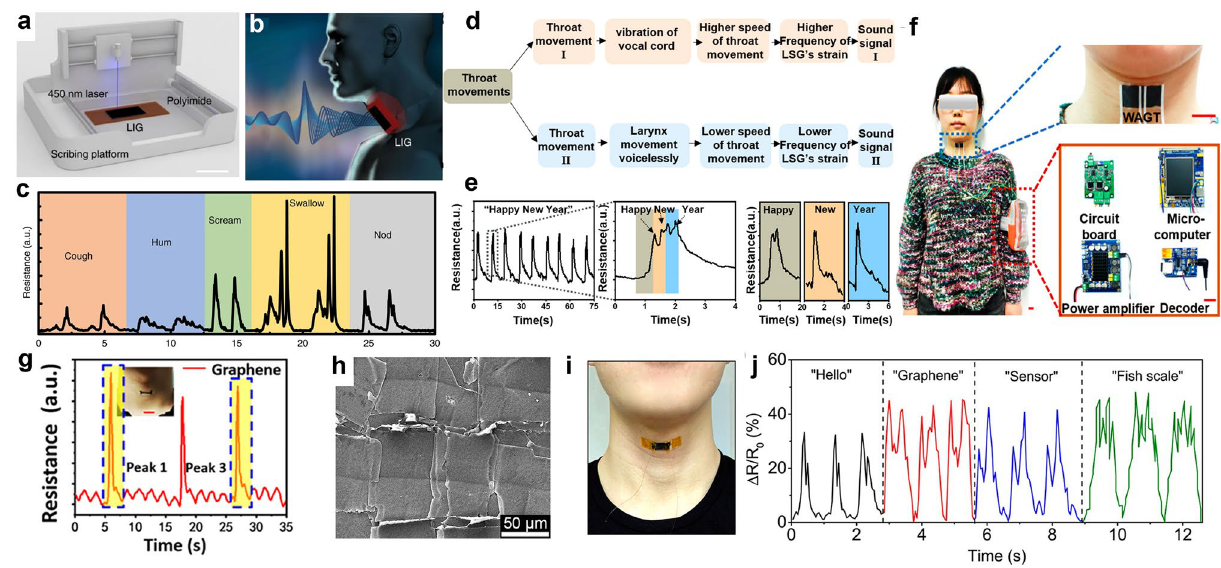
Fig. 11 Soft artificial throat. a One-step fabrication process of LIG. b Artificial throat can detect the movement of throat and generate control- lable sound, respectively. c LIG’s resistance changes toward the throat vibrations of the tester who makes two successive coughs, hums, screams, swallowing, and nods. Reproduced with permission [101]. Copyright (2017), Nature Publishing Group. d Frame diagram of how different throat movements were transformed to different sound signals. e Response of attached LSG toward sound, “Happy New Year”. One wave curve is mag- nified to be showed. f Artificial throat system worn by a tester. Reproduced with permission [256]. Copyright (2019), American Chemical Soci- ety. g Response toward the sound “graphene” and its magnified image. Inset: throat with an attached sensor. Reproduced with permission [233]. Copyright (2018), American Chemical Society. h Top-view SEM images of a fish-scale-like graphene strain sensor. i Photograph of the sensor attached to the throat of a person. j Responsive curves recorded during the processes of speaking “hello”, “graphene”, “sensor”, and “fish scale”, respectively. Reproduced with permission [257]. Copyright (2016), American Chemical